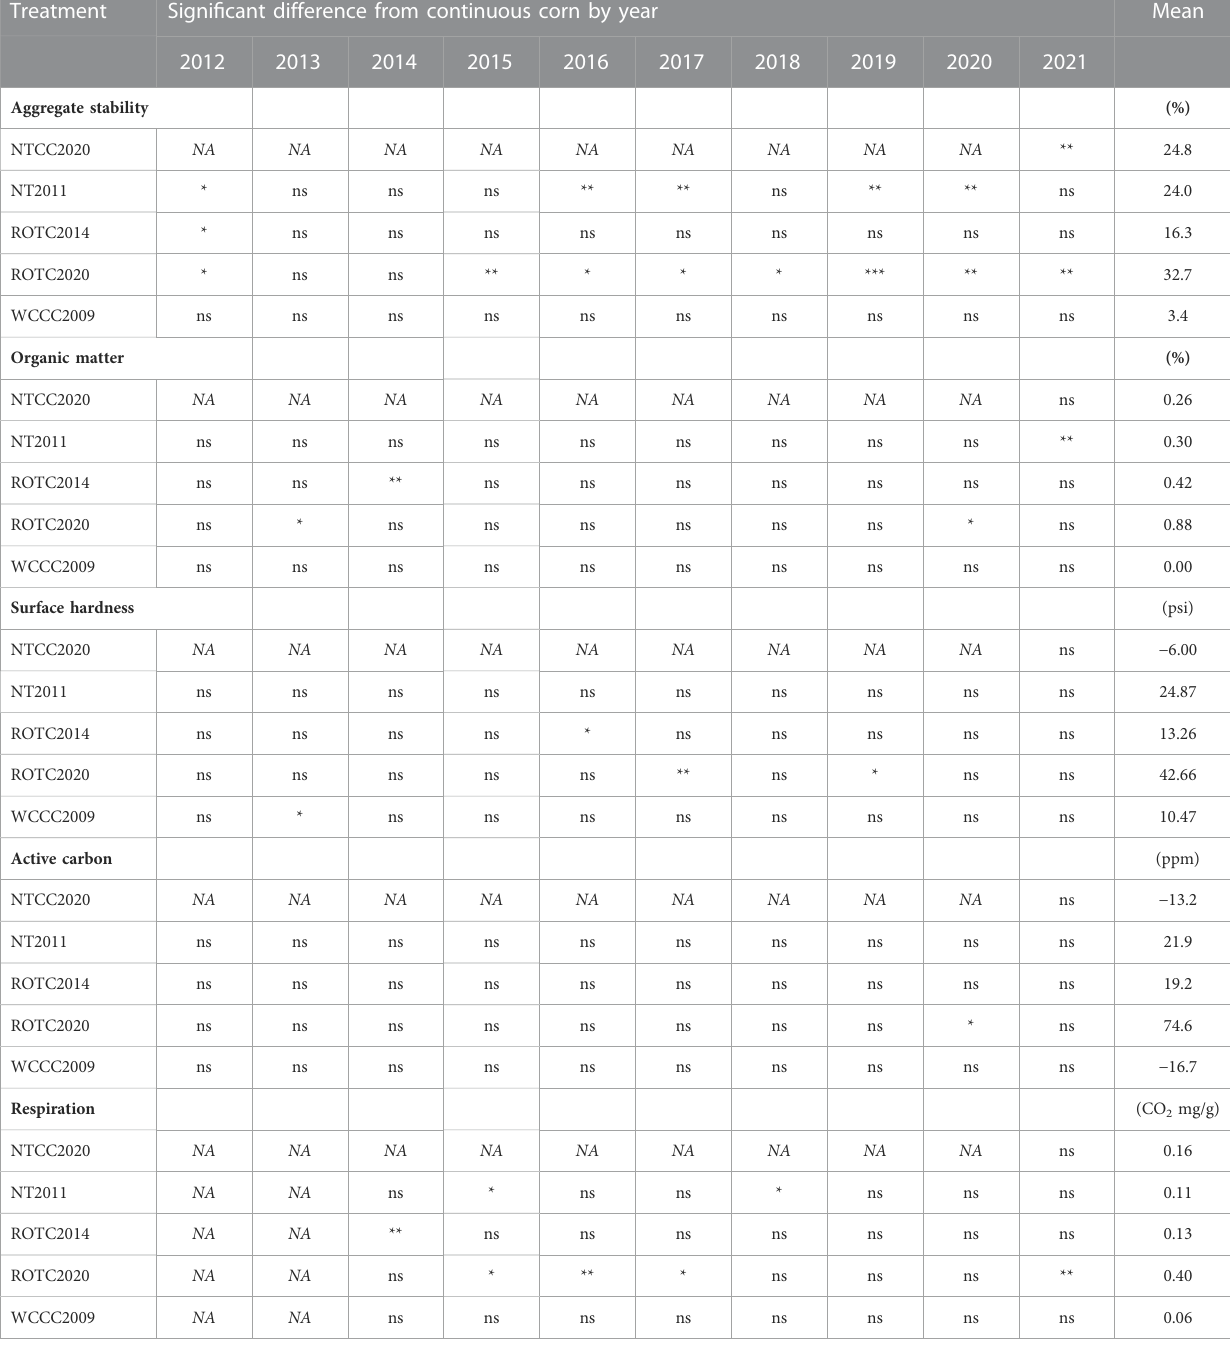
TABLE5Signi fi cancelevelof posthoc Holmcorrectedpairwise t -testcomparisonswithcontinuouscorntreatmentovertimeforsoilvariableswithsigni fi canttime: treatment interactions. NA is no data for that year, ns is not signi fi cant, * is signi fi cant to 0.05, ** is signi fi cant to 0.01, and *** is signi fi cant to 0.001 or less. Mean values over the entire timeframe are in the farm right